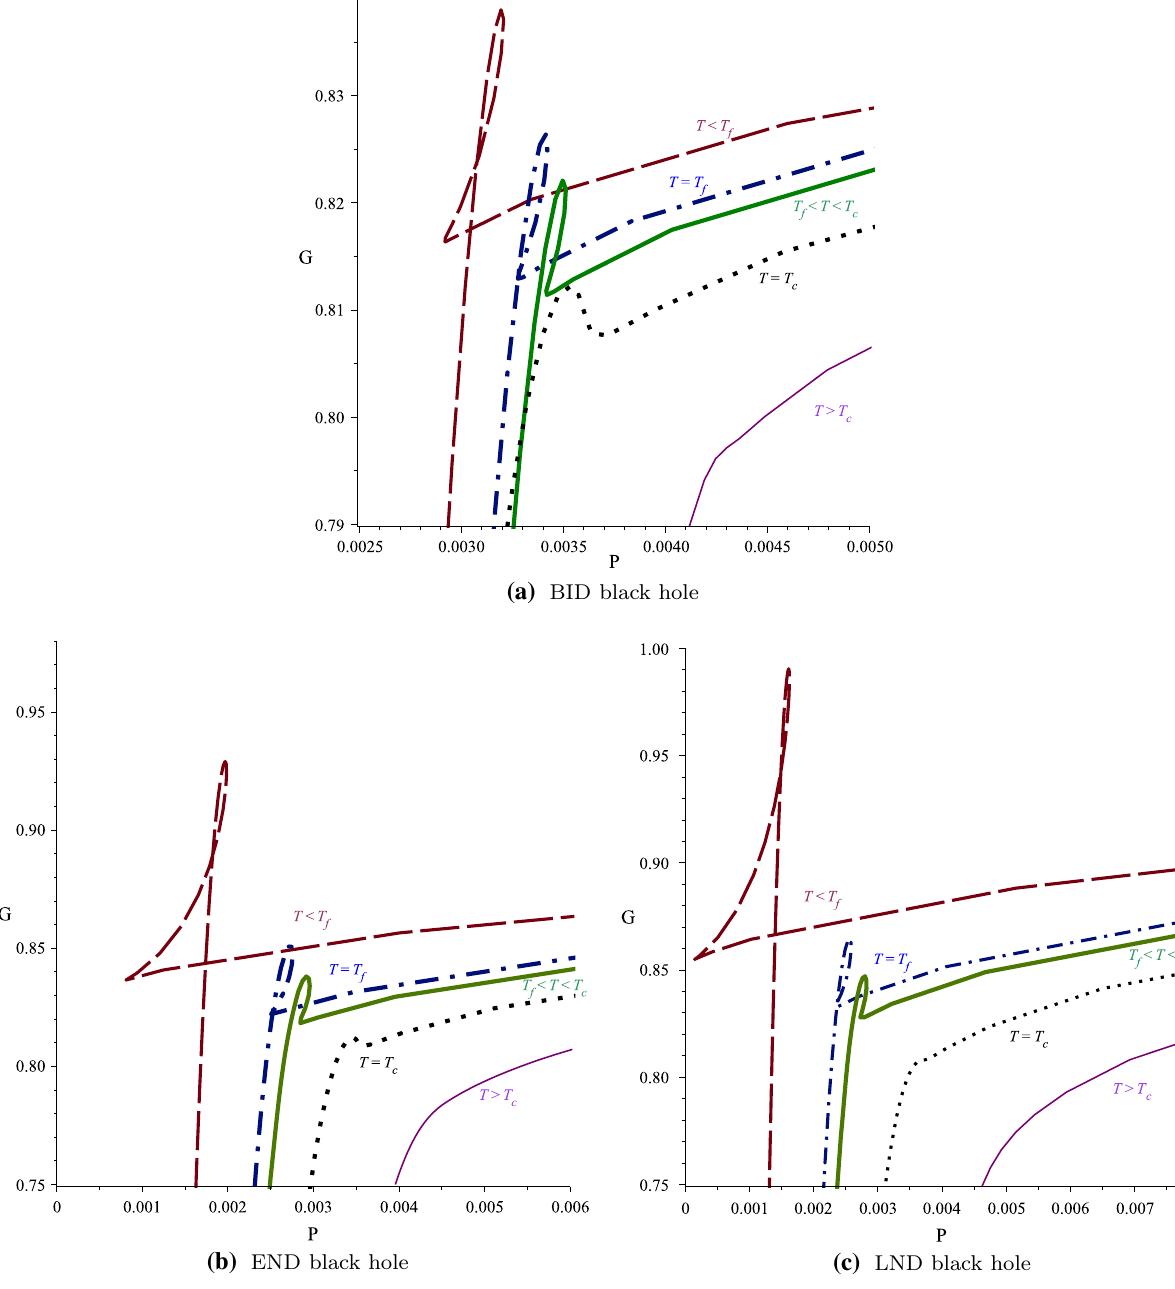
Fig. 12 Gibbs free energy versus pressure for α = 0 . 2, β = 0 . 45 and q = k = b =